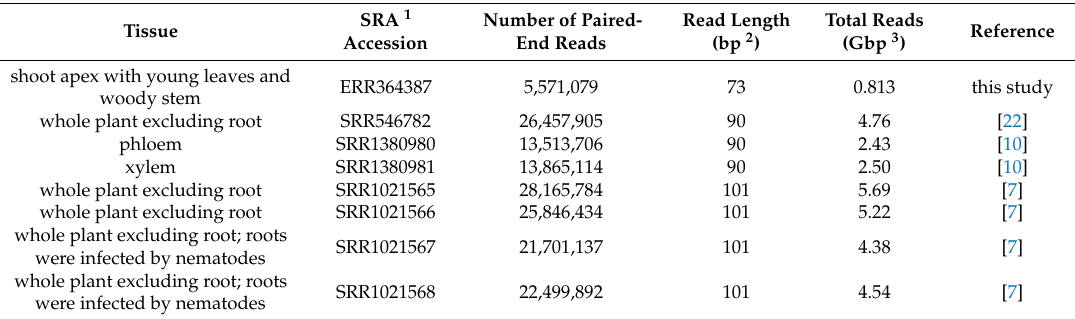
Table 1. Libraries used in transcriptome assembly.